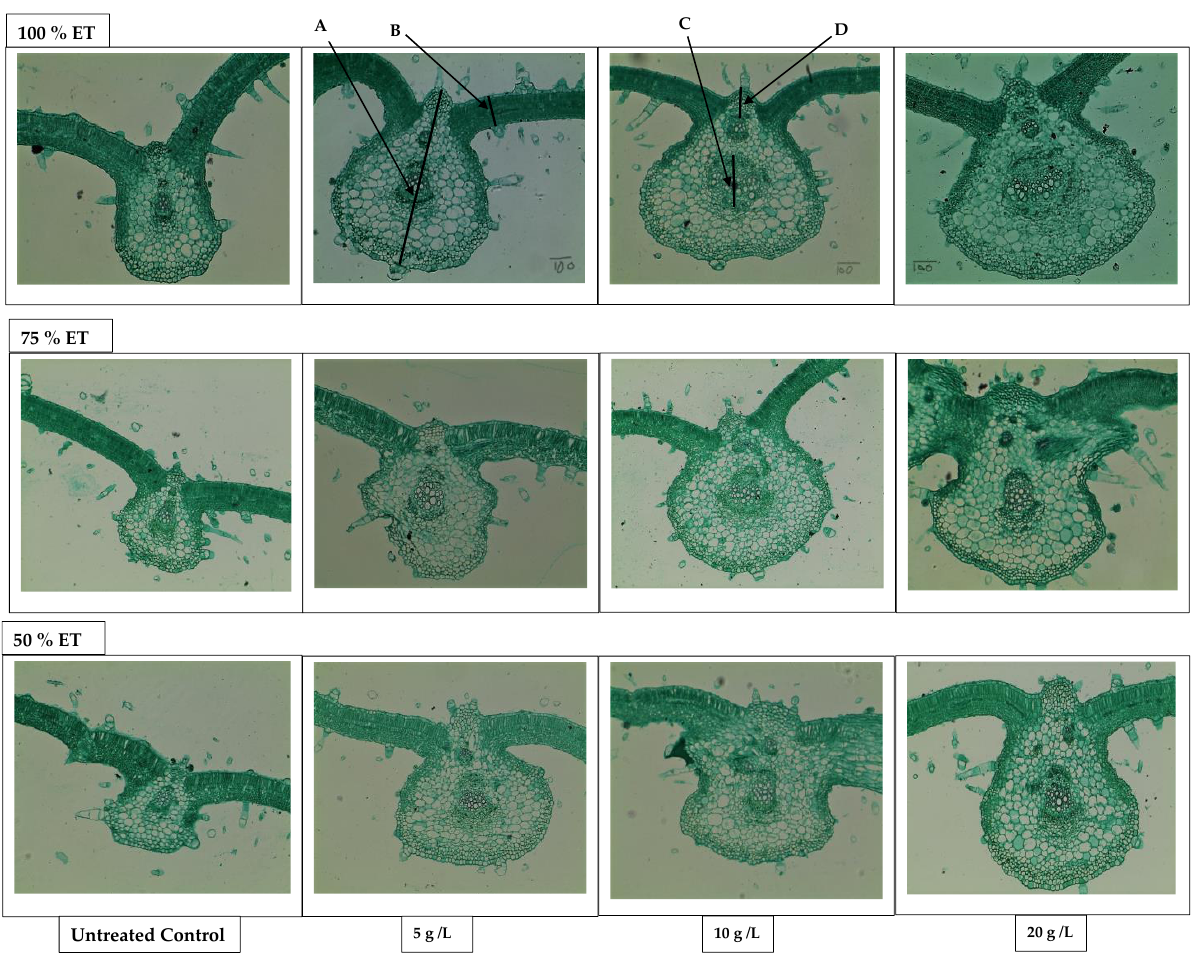
Figure 2. Cross-sections of squash leaves under potassium silicate concentrations and irrigation regimes. A: Periderm, B: Cortex, Bar = 1 00μ, C: Mesophyll thickness (μ), and D: Midrib thickness (μ). (A: Midrib thickness ( µ ), B: Mesophyll thickness ( µ ), C: Vascular bundle thickness ( µ ), and D: Thickness of collenchymatous tissue and epidermis ( µ ). Bar= 100 µ